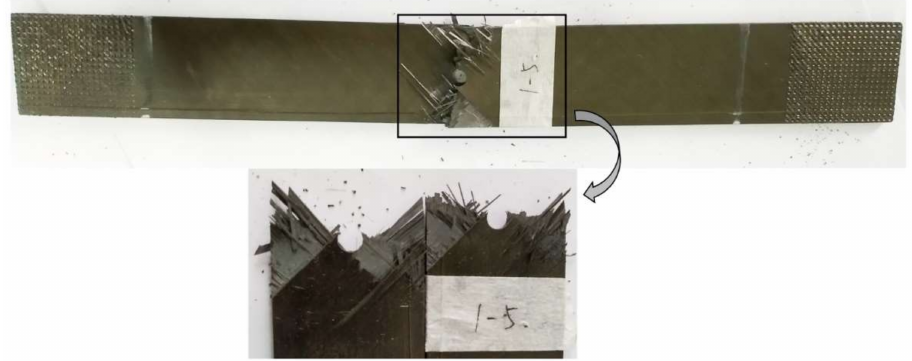
Figure 5. A damage contour in composite laminate specimen numbered